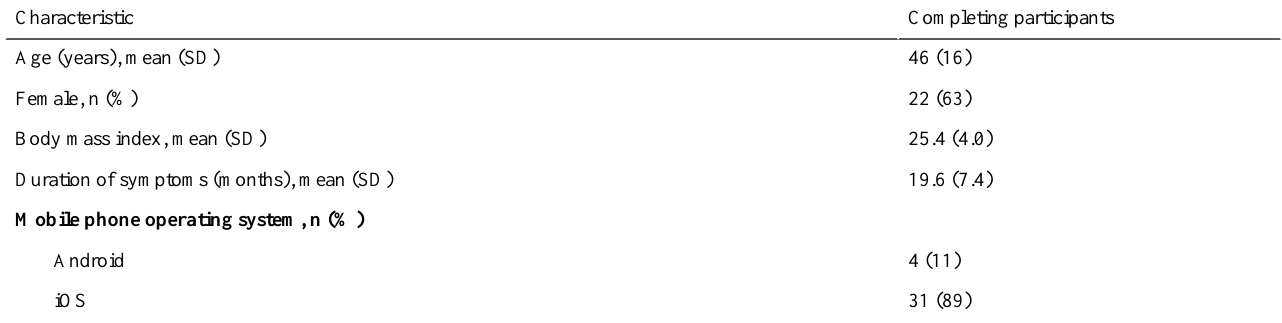
Table 1. Patient characteristics (N=35).